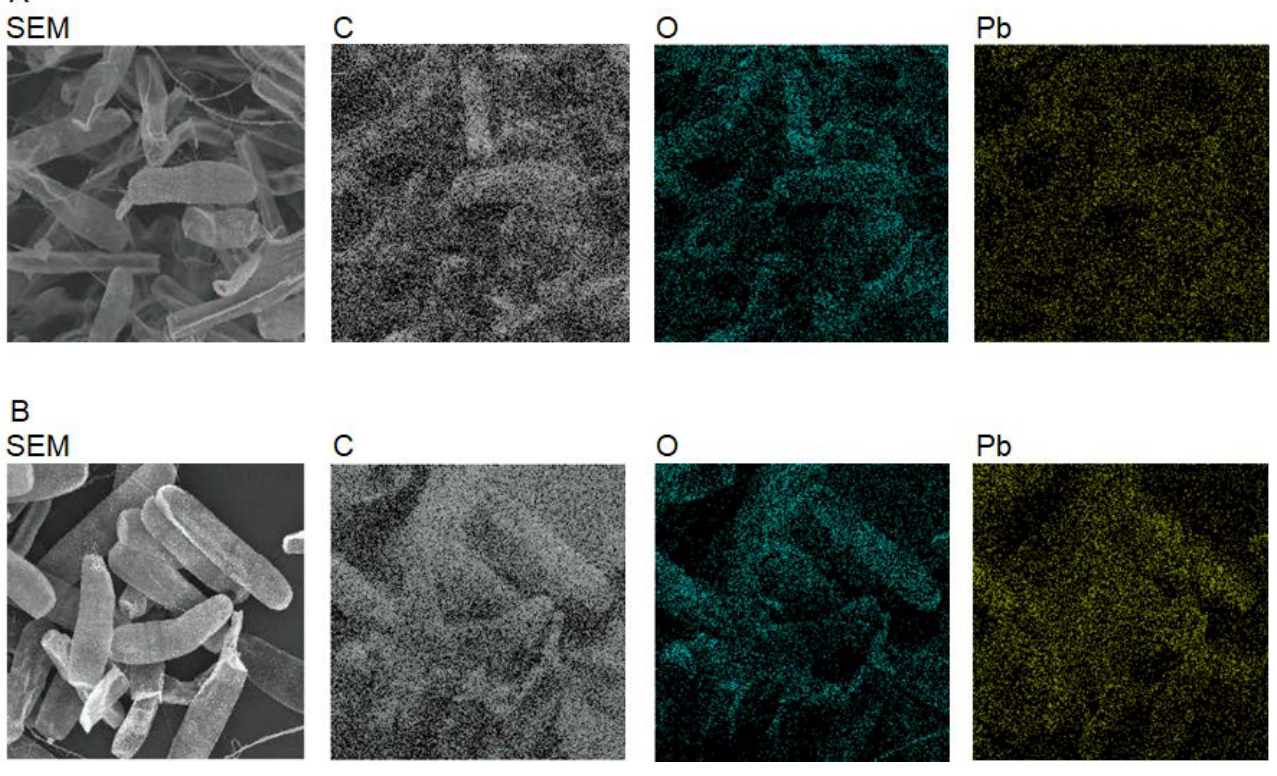
Figure 1. Images of SEM and the elemental mapping of C, O, and Pb in P. margaritaceum cells. Pb- treated NIES-217 ( A ) and NIES-303 ( B ) cells were observed. Pb-treated NIES-217 ( A ) and NIES-303 ( B ) cells were